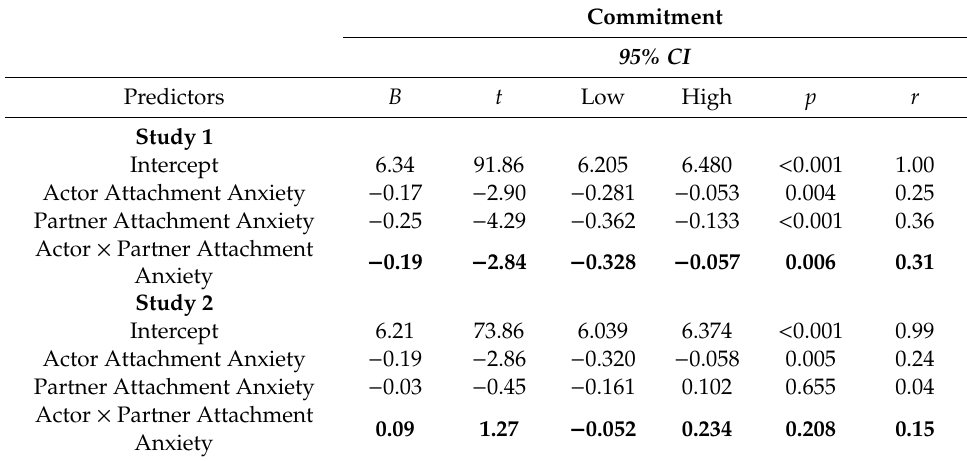
Table 3. The e ff ects of actor and partner attachment anxiety on actors’ daily